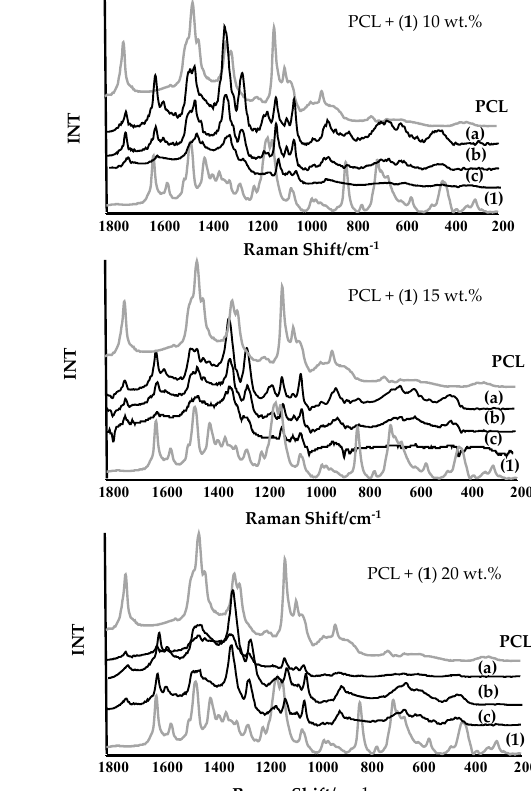
Figure 4. SEM images of PCl and PCL + ( 1 ) n wt.% composites ( n = 10, 15, and 20 wt.%).